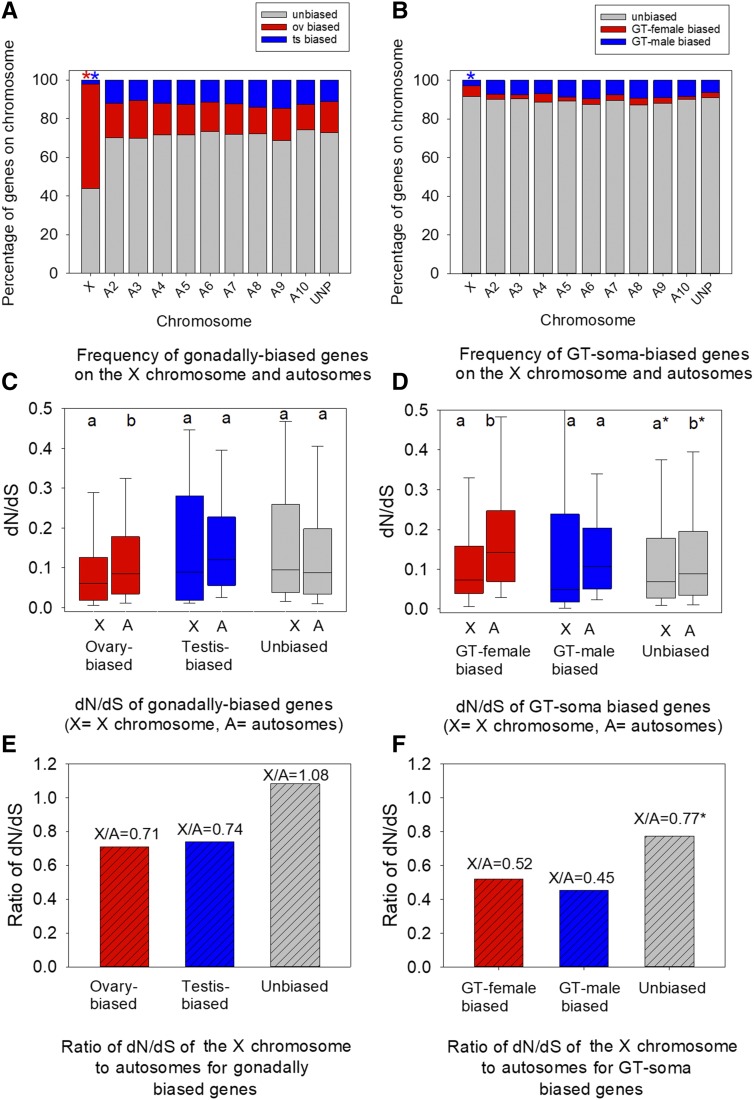
Assessment of the faster-X effect with respect to sex-biased genes in T. castaneum. A) The frequency of gonadally sex-biased genes on the X chromosome and nine autosomes for the 7,751 genes under study; B) the frequency for GT-soma sex-biased genes; C) box plots of the dN/dS of ovary-biased, testis-biased and unbiased genes on the X chromosome and autosomes; D) the dN/dS of GT-male biased, GT-female biased, and GT-unbiased genes on the X chromosome and autosomes; E) the ratio of the median dN/dS of the X chromosome to the autosomes (X/AdN/dS) for all three categories of sex-biased expression for the gonads; and F) for the GT-soma. In A, the red and blue asterisks indicate more ovary-biased and fewer testis-biased (or GT-male biased in B) genes were located on the X chromosomes than on pooled autosomes (Chi2-P with Yates’ correction P < 0.05 for each contrast). Different lowercase letters on top of each pair of bars in C and D indicate MWU-test P < 0.05. In C-F, unmapped genes were included with autosomal genes and their inclusion in or exclusion from the analysis yielded similar results. *Note that differences in X-linked and autosomal unbiased genes in panels D and F are explained by ovary-biased genes as outlined in the main text. ov=ovary, ts=testis.